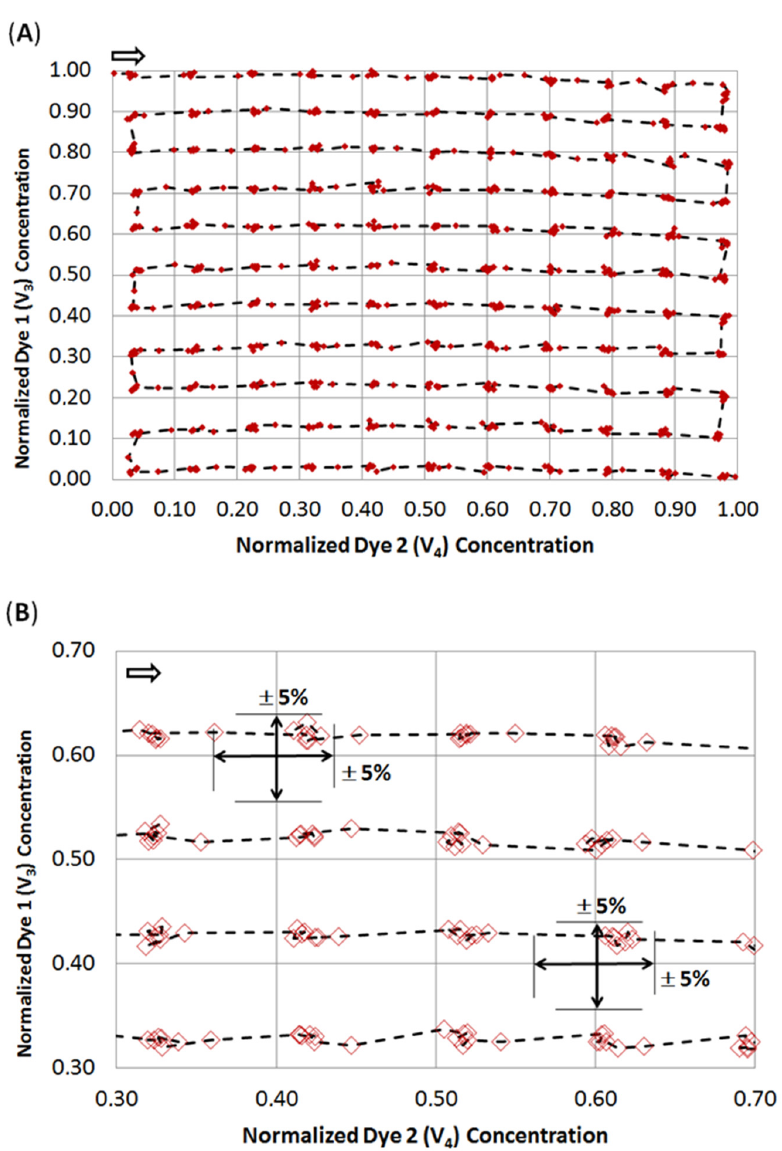
Figure 8. Measured droplet composition screening a 2D concentration space. The droplets were composed of two different dye solutions and diluted by the aspirated sample. The stepwise concentration change set by the flow rate program (Figure 7A) can be clearly seen in the diagram ( A ). The arrow in ( A ) indicates the temporal order of generated droplets regarding the flow rate program (Figure 7A). The deviation or the received droplet composition from the theoretical one is less than 5% for 97% of the droplets. ( B ) Excerpt of the diagram ( A ) showing the measured droplet composition in greater detail.